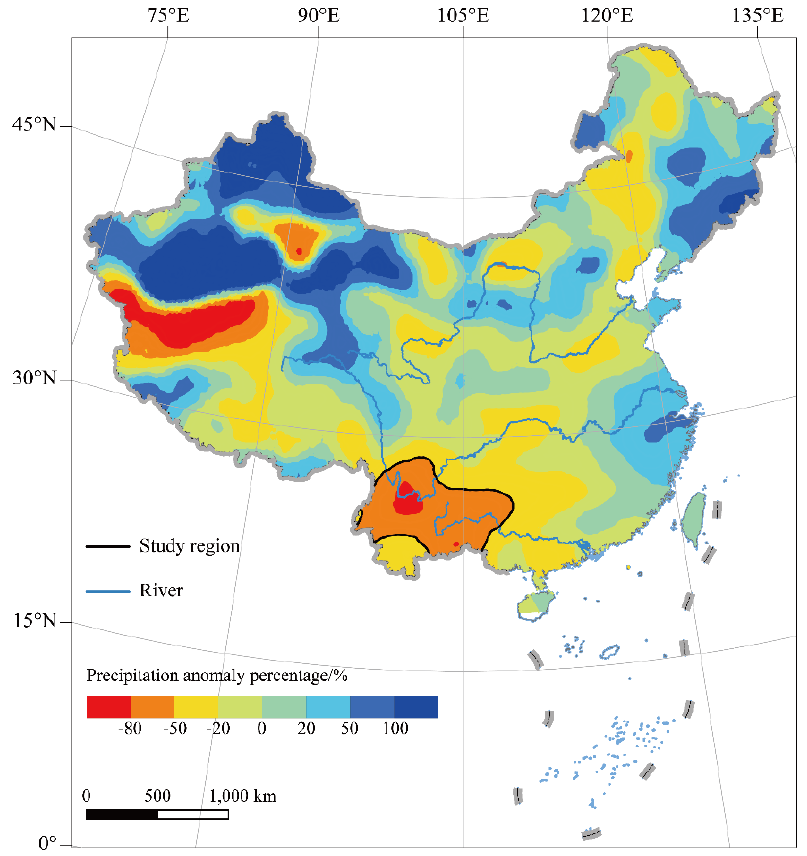
Figure 1. Location of the study region and precipitation anomaly percentage from October 2009 to March 2010 relative to the 1971–2000 period based on CRU